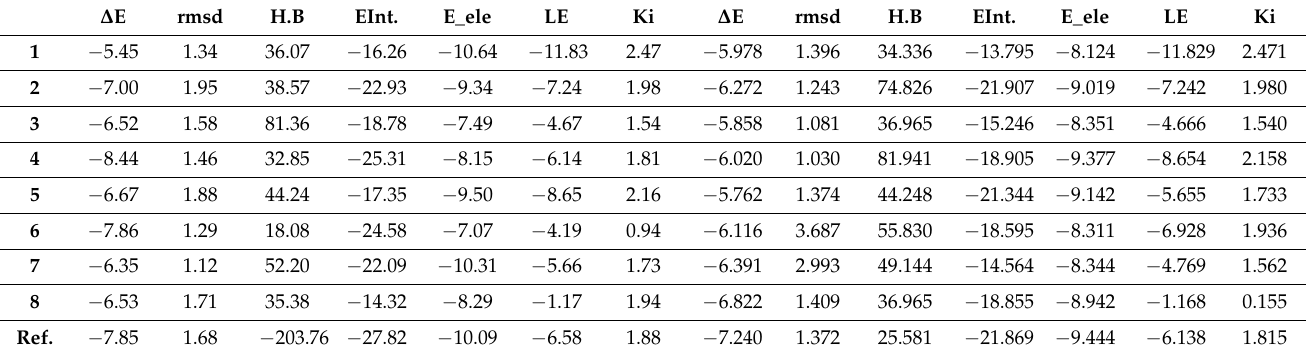
Table 3. The binding affinity (kcal/mol) for 1 – 8 against different proteins, including DHFR and DNA gyrase with reference inhibitors Methotrexate and